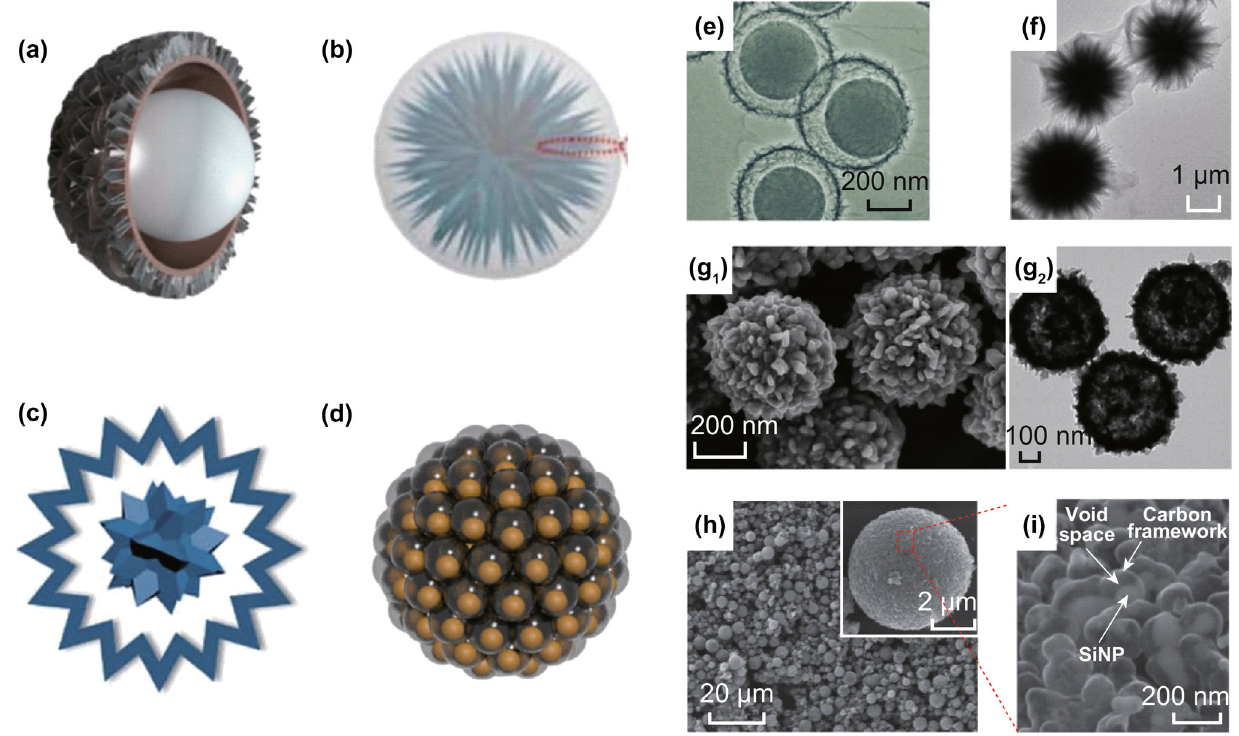
Fig. 2 Schematic demonstration of novel YS structure of: a polystyrene spheres (PS)@NiCo 2 S 4 . Reprinted with permission from Ref. [71]; b urchin-like Bi 2 S 3 @polypyrrole(ppy). Reprinted with permission from Ref. [72]; c rough VO 2 microspheres. Reprinted with permission from Ref. [73]; and d pomegranate-like Si@C. Reprinted with permission from Ref. [75]. The corresponding TEM images of e PS@NiCo 2 S 4 ,